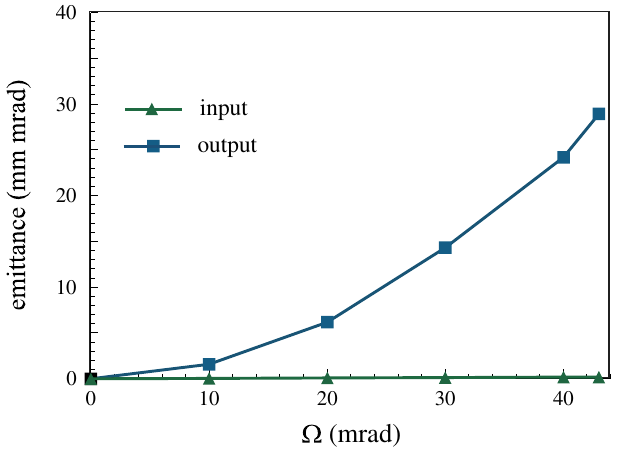
FIG. 10. Emittances for different opening angles into solenoid ( (cid:2) E=E ¼ (cid:2) 0 : 05 ).